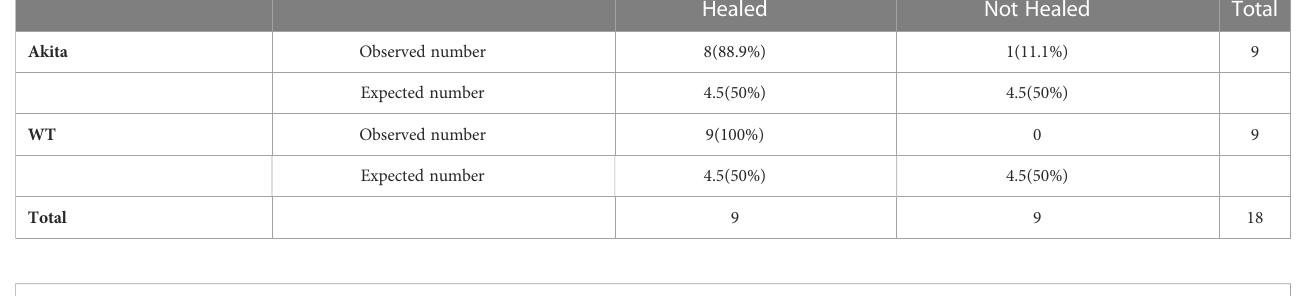
TABLE 2 Contingency table for Pearson chi-square test analysis of number and percentage (in brackets) of WT and Akita mice healed at day 7 after corneal alkaline injury (degrees of freedom = 1, signi fi cance level = 0.05).